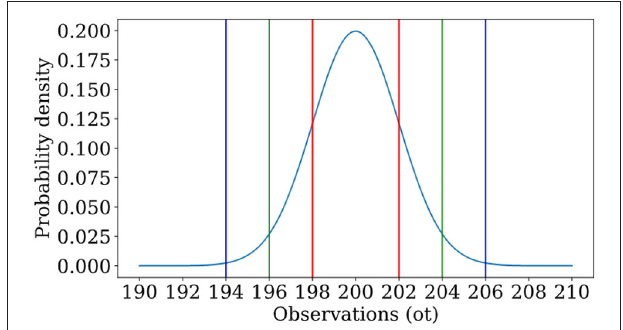
FIGURE 2 | An example of a normal distribution, in which a random variable has probability density function ρ ( x ) observation is governed by how many standard deviations one is away from the mean. Lines indicate locations at which one is 1 (red), 2 (green), or 3 (blue) standard deviations from the